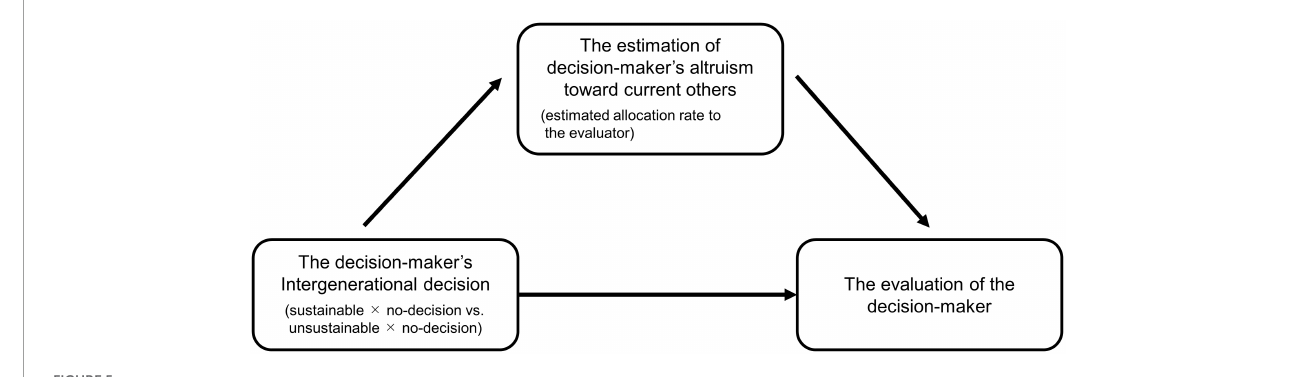
FIGURE5 The mediation model investigated in Study